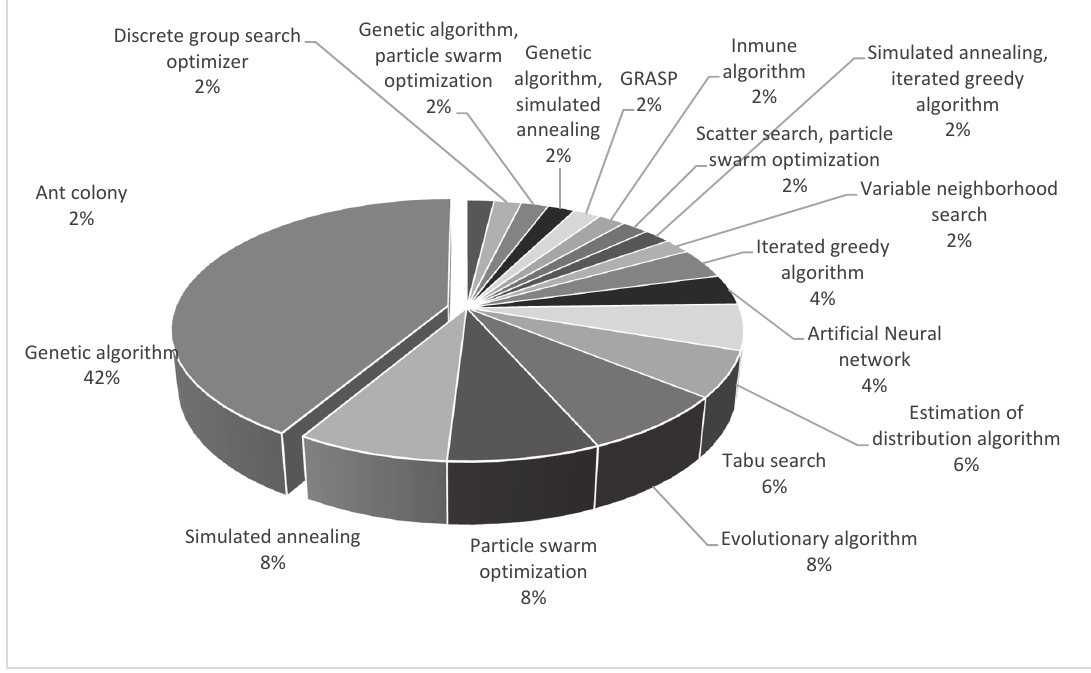
Fig. 5. Distribution of